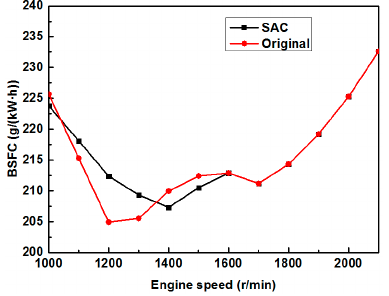
Figure 6. Full load optimization results: BSFC.